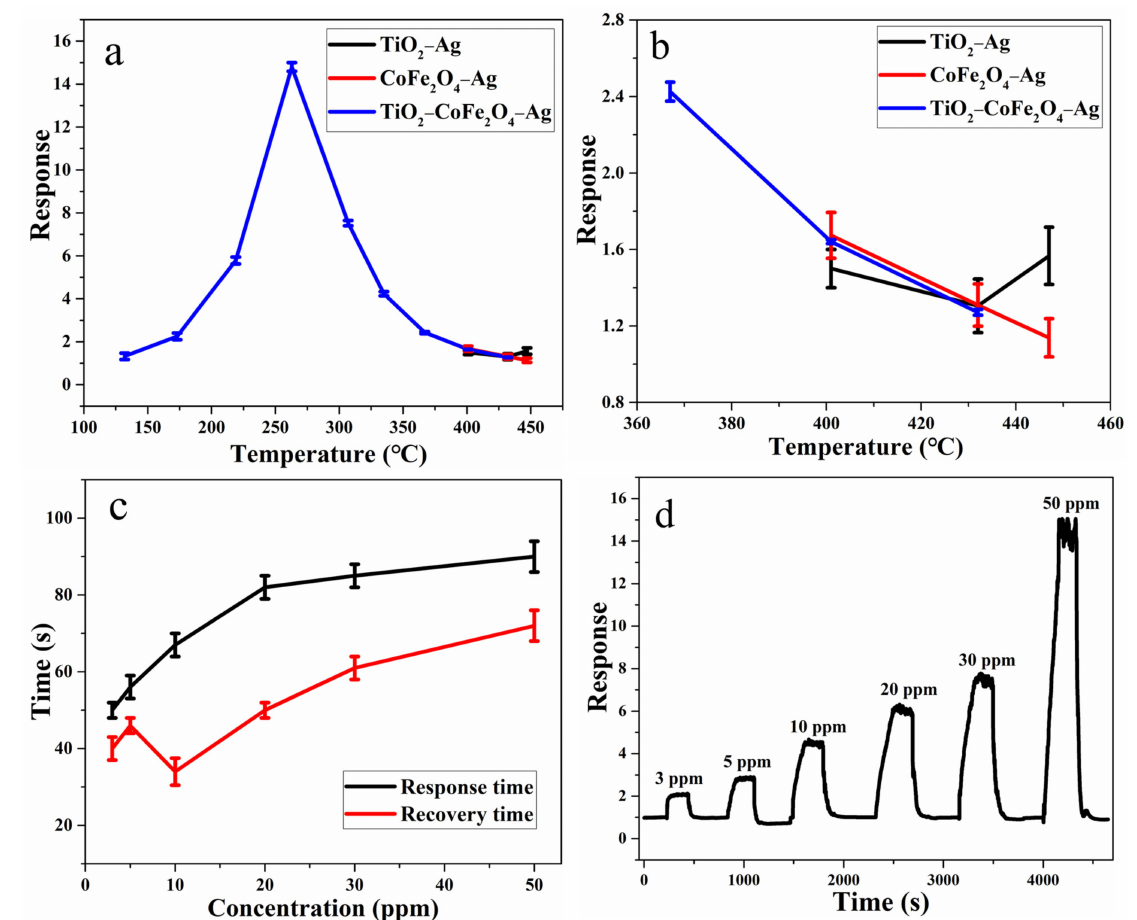
Figure 5. ( a ) Gas-sensitive response test to toluene at different temperatures ( n = 3), ( b ) gas-sensitive response test to toluene at 360–455 ◦ C ( n = 3), ( c ) response/recovery time ( n = 3), and ( d ) dynamic response of TiO 2 − CoFe 2 O 4 − Ag to toluene gas at 263 ◦